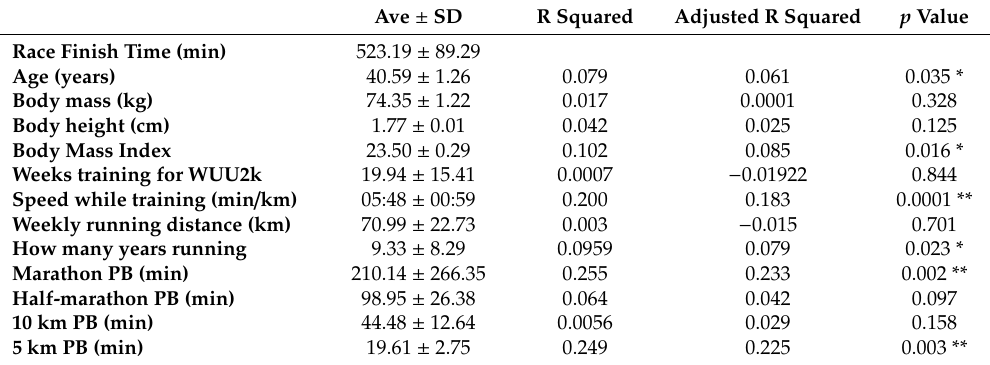
Table 2. Male bivariate analysis (n =